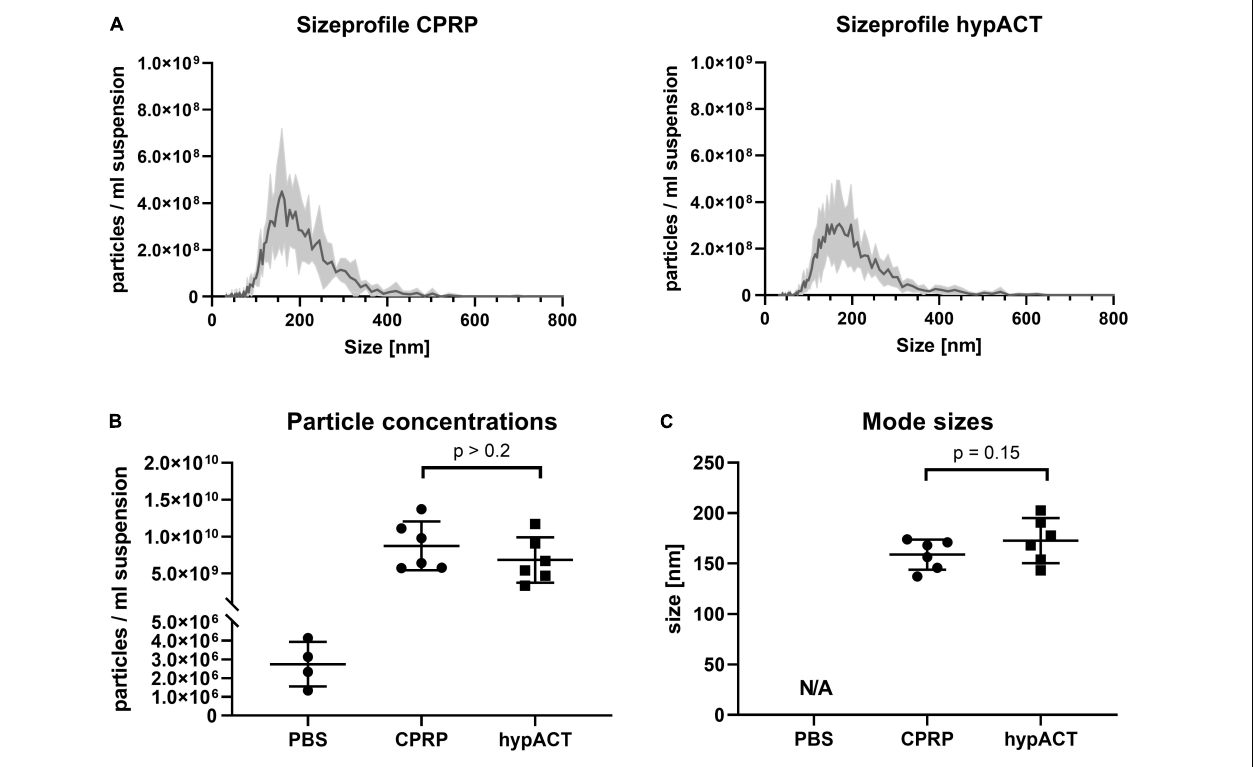
FIGURE 3 | Characterisation of particles in pellets after ultracentrifugation (P100 fractions) via nanoparticle tracking analysis (NTA). (A) Size profiles of citrate-anticoagulated platelet-rich plasma (CPRP) and hyperacute serum (hypACT). (B) Total particle concentrations in the EV suspensions or eluent (PBS). (C) Mode size of particles determined in 6 Donors. Determination of mode size was not possible in PBS (N/A, not a number) as the number of recorded traces was too low, as expected, to reliably determine particle sizes. Data are given as mean ±